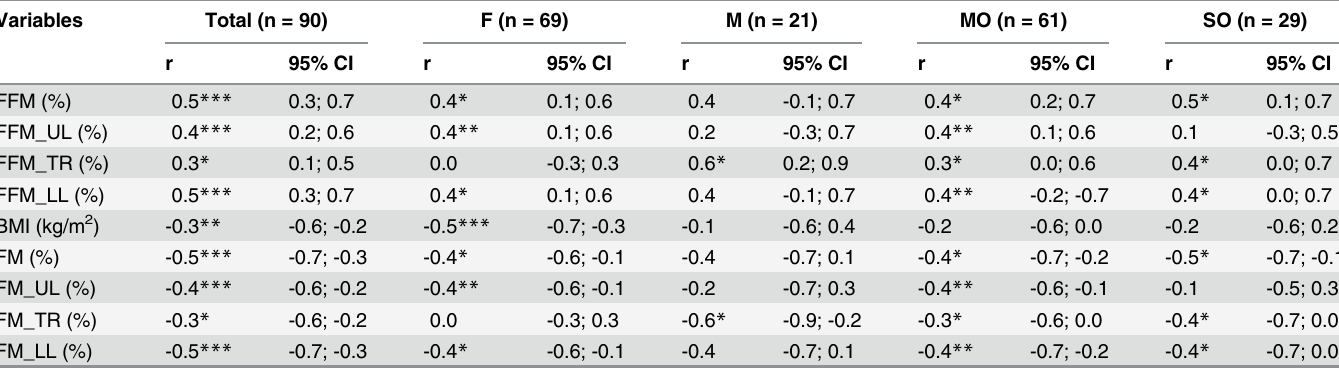
Table 4. Correlation between 6MWD and body mass